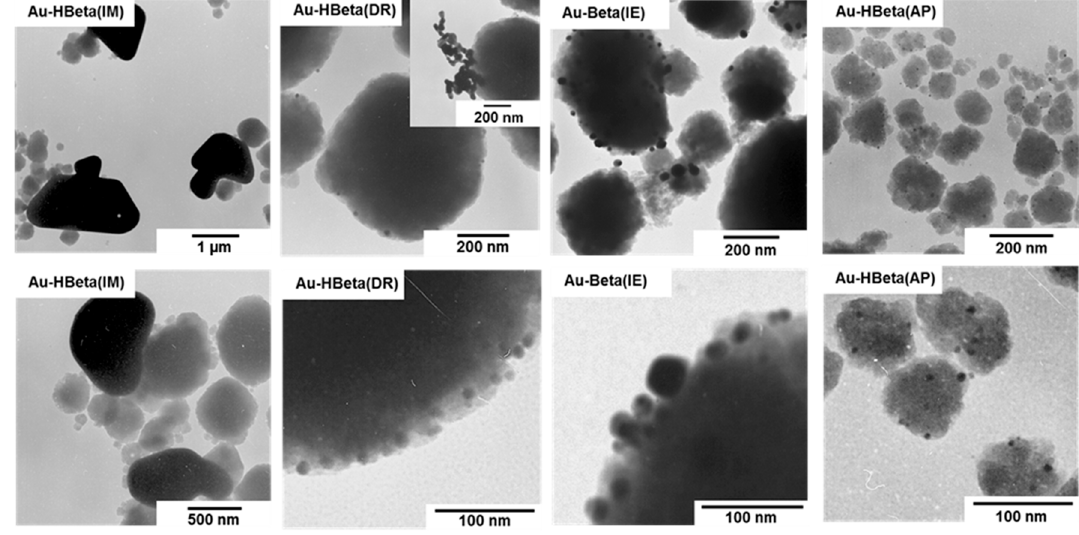
Figure 3. TEM images of prepared materials.